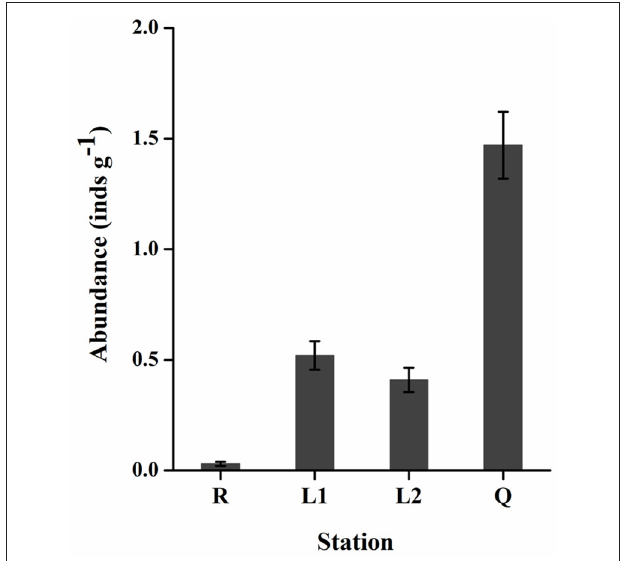
FIGURE 4 | The abundance of Apohyale sp. in floating U. prolifera mats at 4 stations of YSGT. Error bars are SE ( n = 3). YSGT, green tides in the Yellow